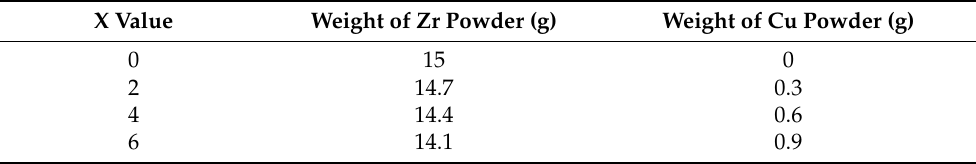
Table 1. Composition of Zr 100-x Cu x (x = 0, 2, 4, 6) film. X Value Weight of Zr Powder (g) Weight of Cu Powder